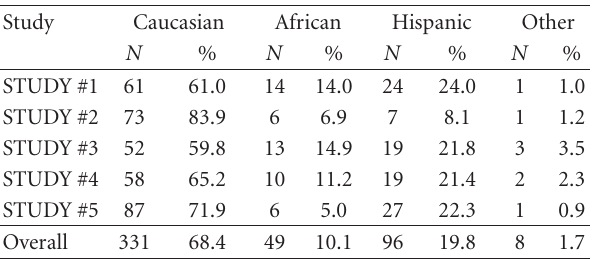
Table 2: Race distribution by study.